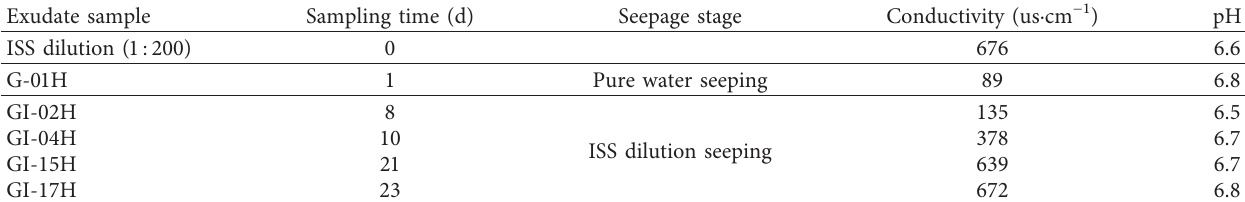
Table 4: Plasticity index of red clay treated by different ISS/H